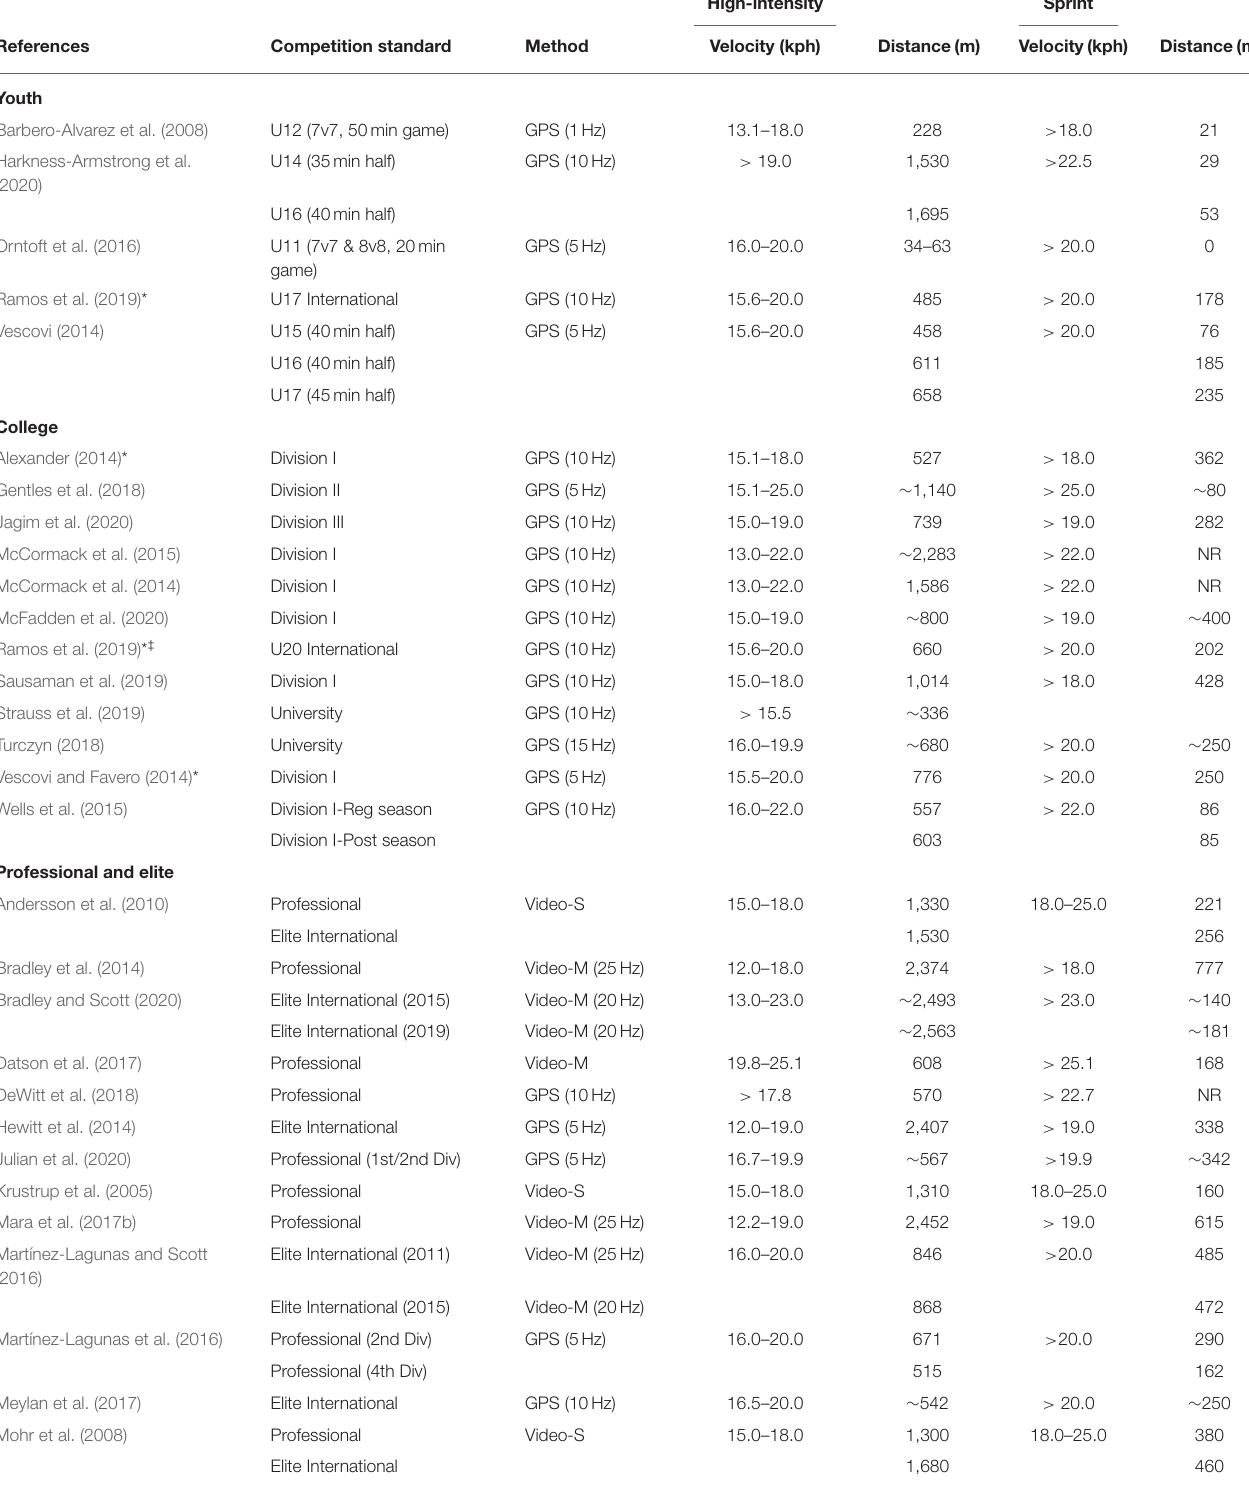
TABLE 1 | Velocity thresholds and distances for high-intensity running and sprinting across